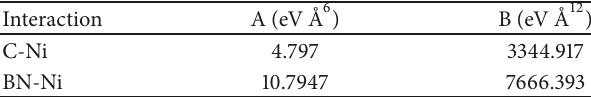
Table 1: Numerical values of the attractive and repulsive